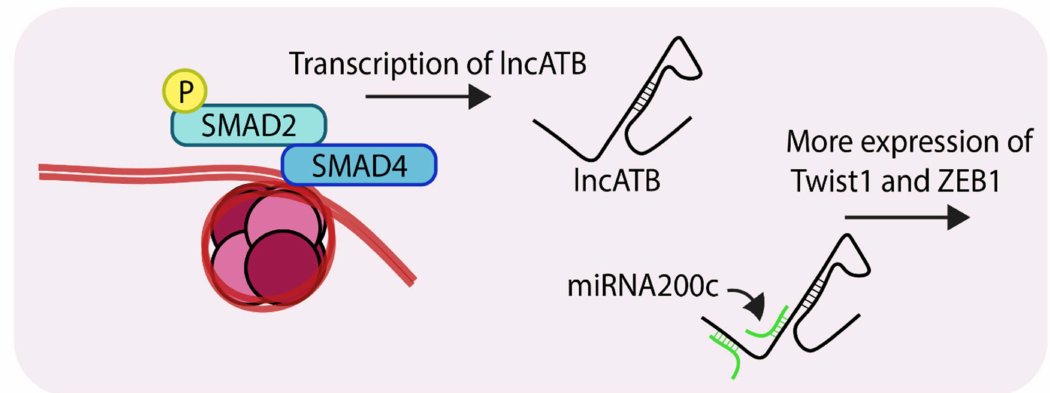
Figure 5. Representation of SMAD-mediated transcription of lncATB (Long non-coding RNA, activated by TGF- β ). LncATB acts as sponge to soak up miRNA200c, which is a negative regulator of TWIST1 (Twist family bHLH transcription factor 1), this ultimately leads to its enhanced levels. ‘P’ in yellow circles indicates